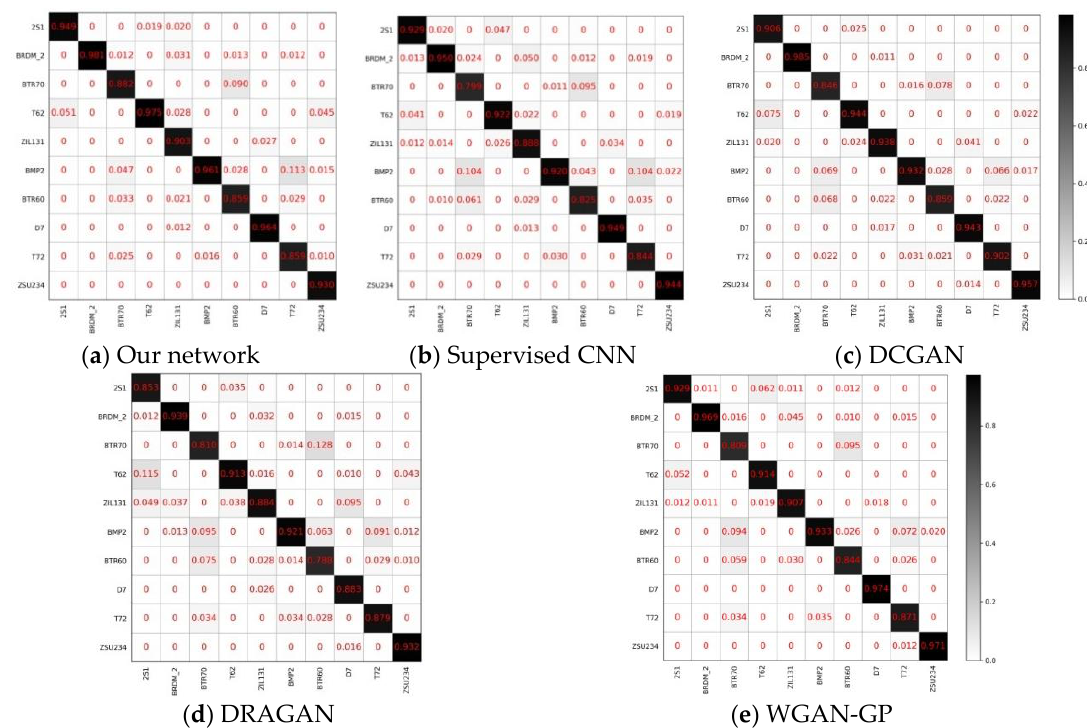
Figure 9. The average confusion matrix of ( a ) our network; ( b ) supervised CNN; ( c ) DCGAN; ( d ) DRAGAN; and ( e ) WGAN-GP (64 × 64). The average classification accuracy of our method is